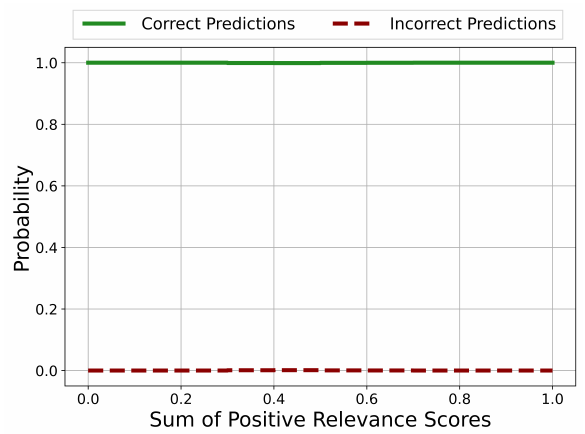
Figure 12. Probability distribution of the sum of positive Relevance scores for correct (green solid line) and incorrect (red dashed line) predictions on the test set. For each value, the probability of the prediction being incorrect is practically